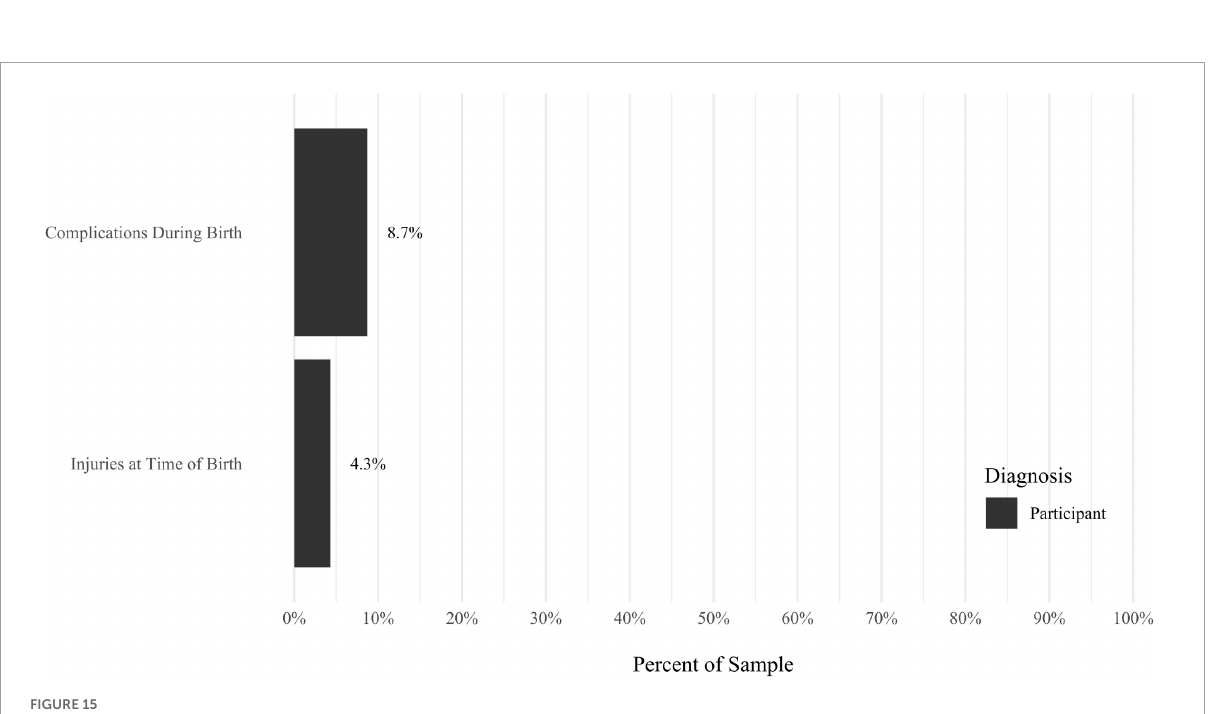
FIGURE15 Rates of medical health problems: birth